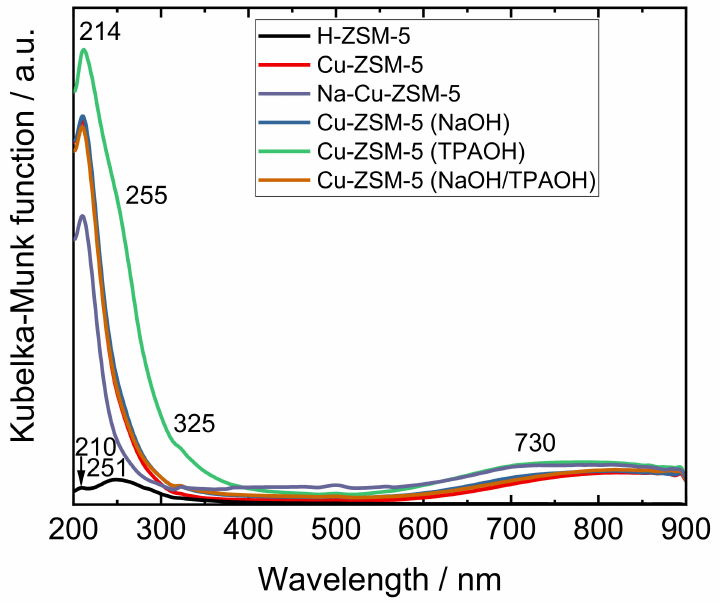
Figure 5. DR UV-Vis spectra of H-ZSM-5, micro-/mesoporous Cu-exchanged ZSM-5 and Cu-exchanged ZSM-5 with co-cation.